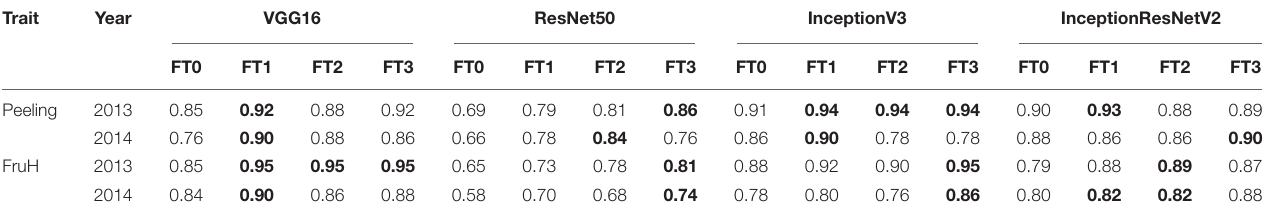
TABLE 3 | Classification accuracy of deep learning